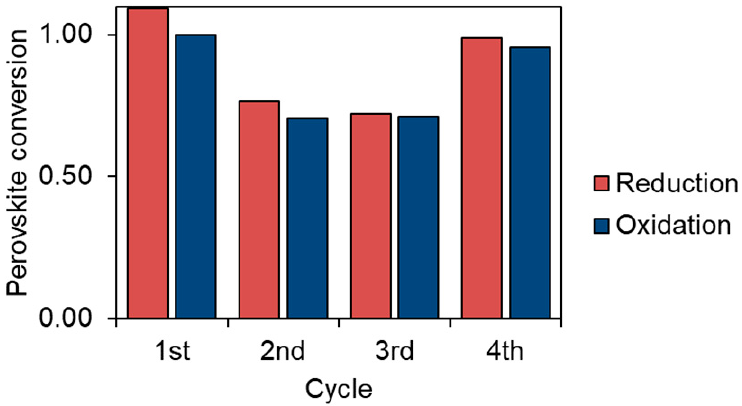
Figure 10. Isothermal cycles at 900 °C.